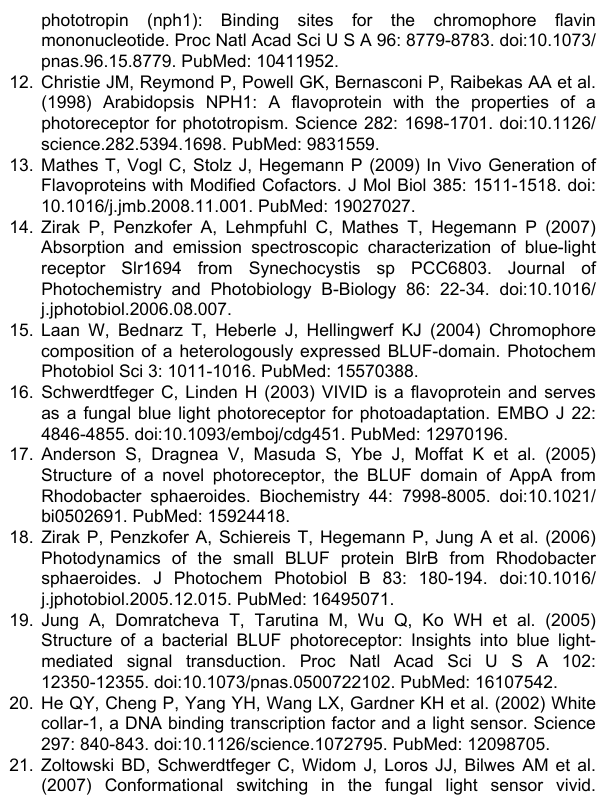
Figure S7. Polar interactions between FMN and arginines R 63 and R 79 of the YtvA LOV domain. Close-up of the YtvA LOV domain structure (PDB-ID: 2PR5 [29]) showing polar interactions (green dotted lines) between the phosphate group of FMN and the side chains of arginines R 63 and R 79 . Heteroatoms are color-coded: nitrogen (blue), oxygen (red), phosphor (orange).